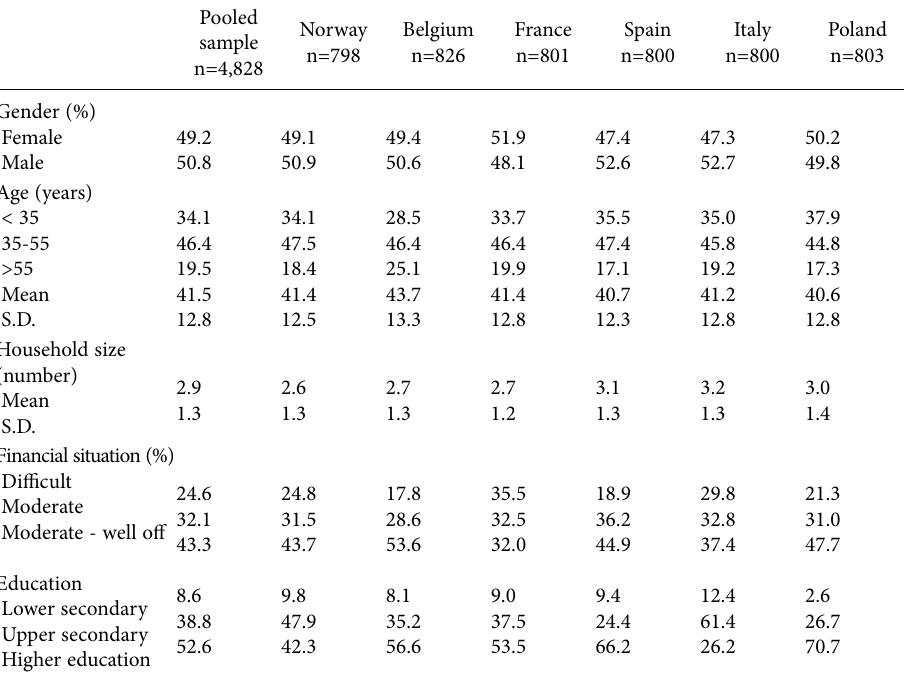
Table 1. Selected socio-demographic characteristics of the pooled and national